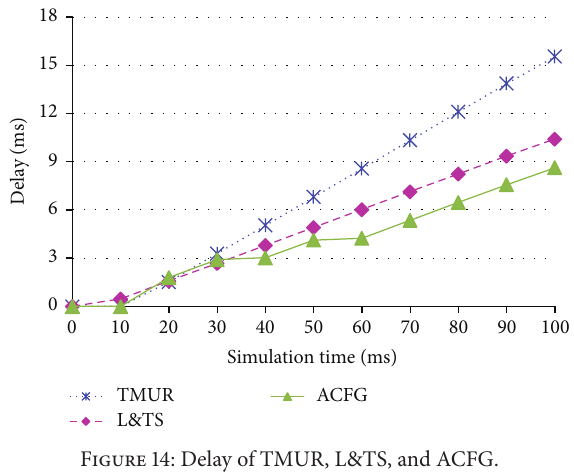
Figure 14: Delay of TMUR, L&TS, and ACFG.